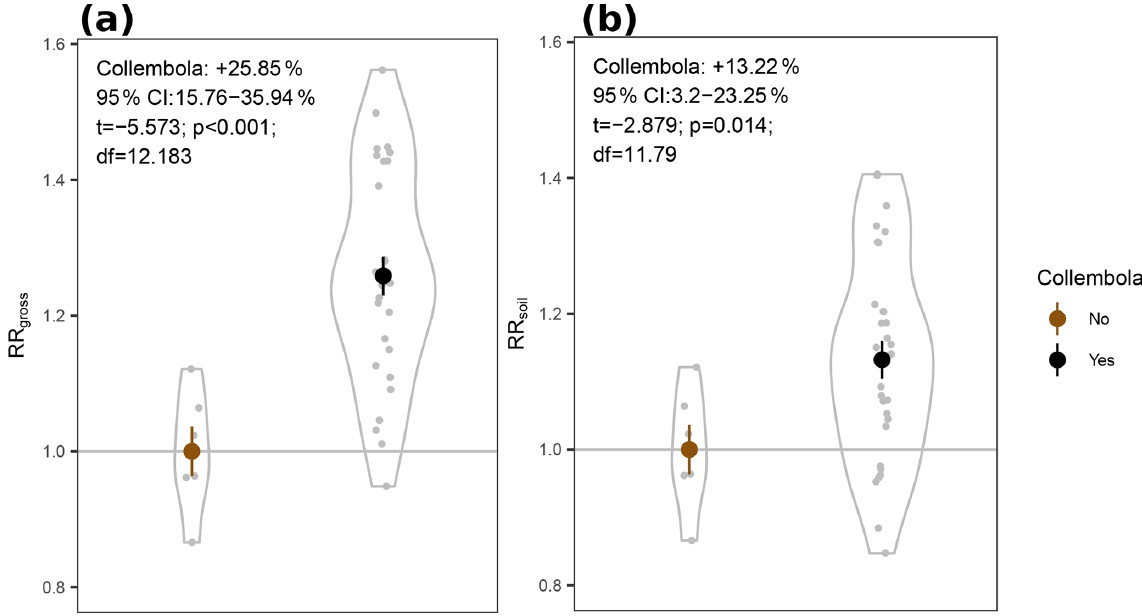
Figure 4. Response ratios of permafrost cumulative CO 2 production rates to addition of Collembola. (a) RR gross : measured CO 2 production rates. (b) RR soil : measured CO 2 production rates with estimated Collembola basal respiration subtracted. All values are divided by the mean of the no-Collembola control; small grey circles are individual values; large symbols are means; error bars are standard errors of the mean ( n = 6 and 30 for brown and black symbols, respectively); violin plots denote the shape of the distributions with the maximum width proportional to the number of observations. Statistics are derived from two-sample t tests with unequal